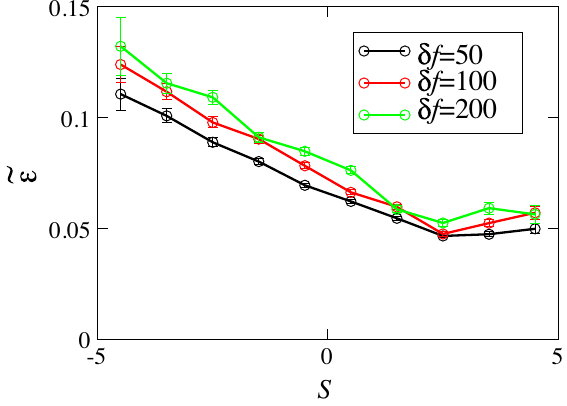
FIG. 8. The amount of shear strain exerted to the local environment of a particle before it starts to rearrange versus the softness of that particle, observed 50, 100, and 200 frames before the